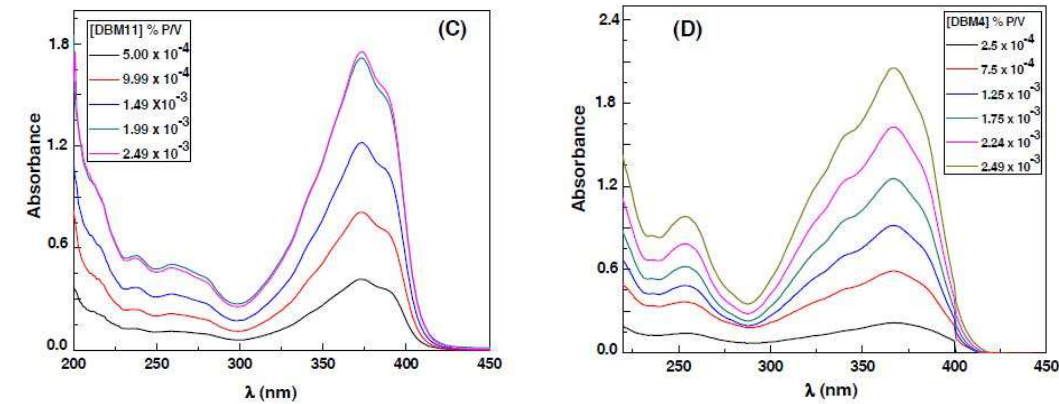
Figure 4. Absorption spectra of dibenzoylmethanes: ( A ) DBM1; ( B ) DBM2; ( C ) DBM11; ( D ) DBM4.